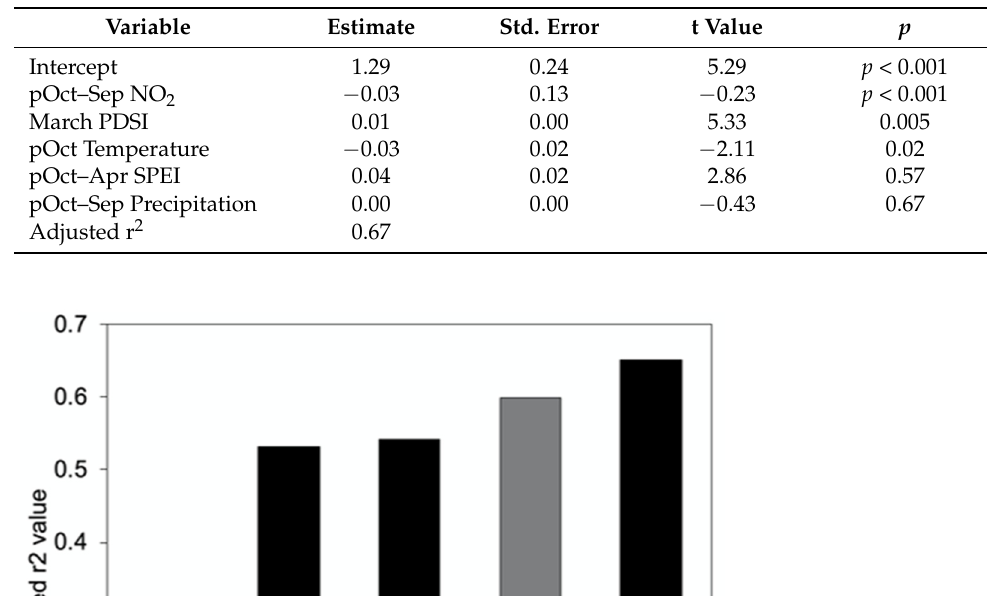
Table 3. Output from the stepwise regression model identifying significant variables. .